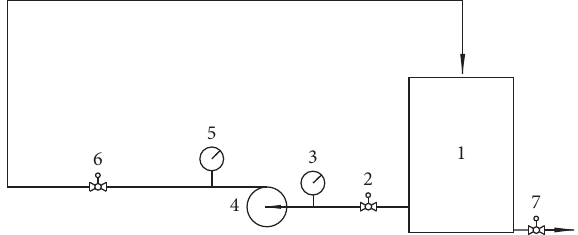
Figure 3: A schematic view of experimental rig. 1: tank. 2: valve. 3: pressure transmitter. 4: vortex pump. 5: pressure transmitter. 6: